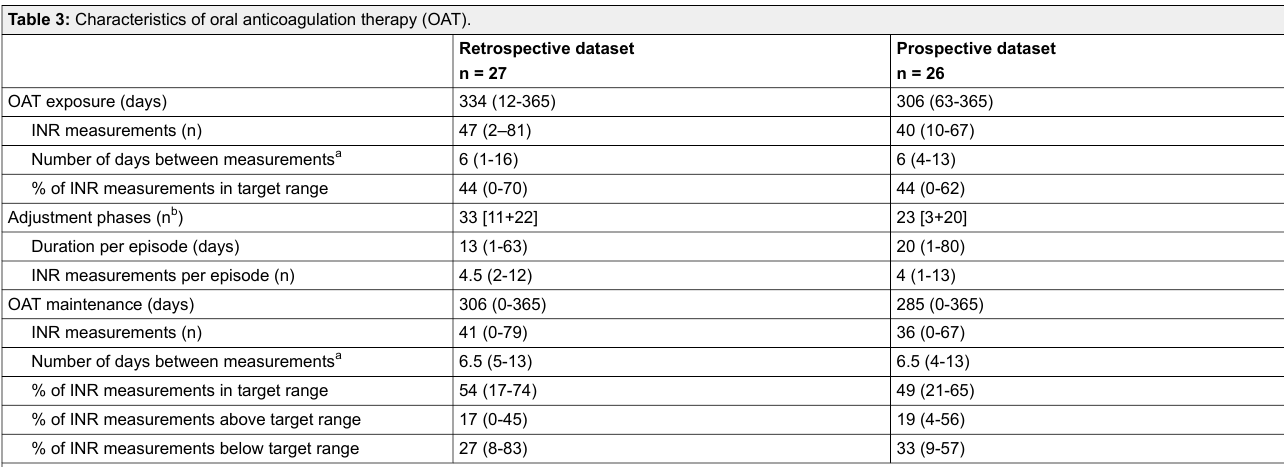
Table 3: Characteristics of oral anticoagulation therapy